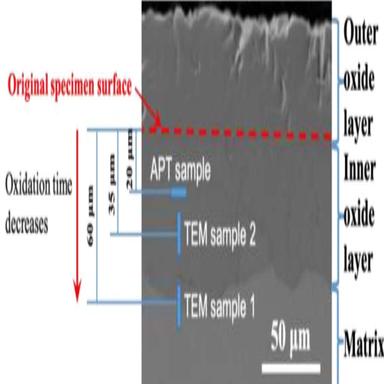
(a) BFTEM image showing the TEM sample 1 prepared at the inner oxide layer-metal matrix interface and high-resolution BFTEM image showing that the inner oxide layer consists of two phases; (b) SAED pattern taken at Region A in (a) showing an austenite phase of the metal matrix; (c) SAED pattern taken at Region B in (a) showing the existence of double diffraction in the inner oxide layer; (d) SAED pattern taken at Region C in (a) showing that the SAED pattern obtained from the metal matrix is coherent with t